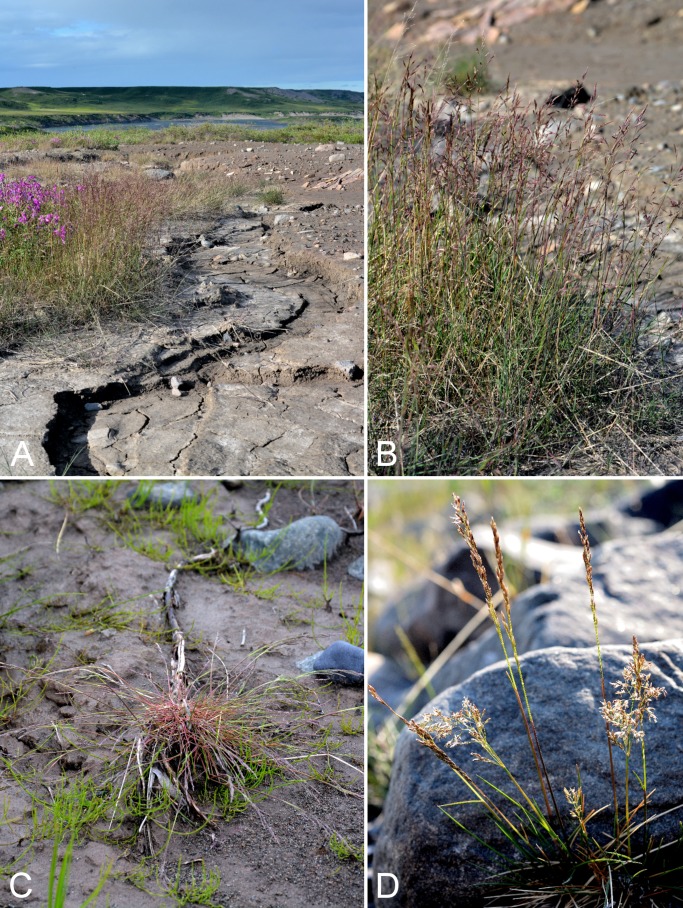
Puccinellia arctica and Puccinellia nuttalliana.Puccinellia arctica: (A) habitat, Saarela et al. 4088. (B) Habit, Saarela et al. 4088. Puccinellia nuttalliana: (C) habit, Saarela et al. 4126. (D) Inflorescence, Saarela et al. 3797. Photographs by P. C. Sokoloff (A, B, C) and R. D. Bull (D).